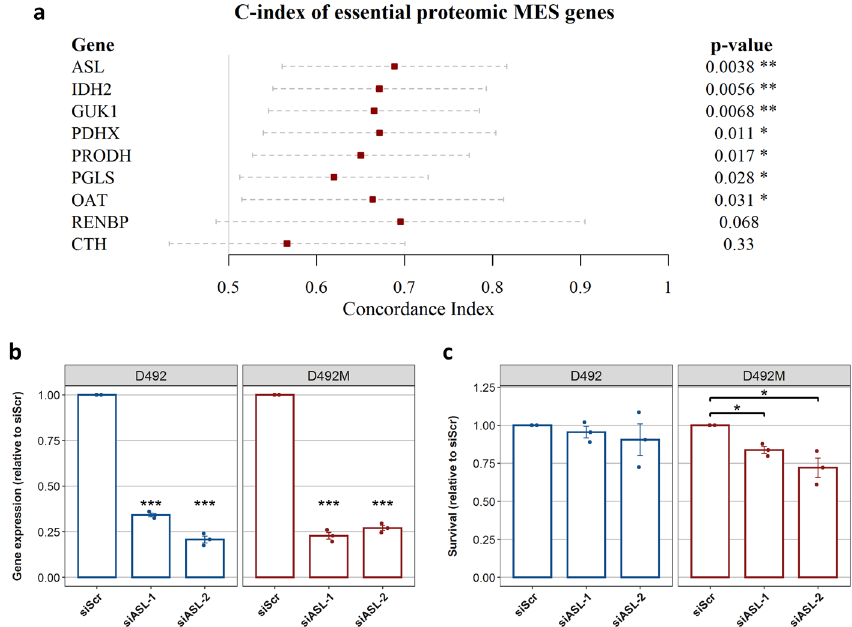
Fig. 5 Selection and knockdown of MES-essential genes. a Concordance index (C-index) of proteomic MES essential genes for overall survival prediction of patients with claudin-low breast tumors. Lines represent 95% con fi dence intervals and p values are from the calculation of the C-index using Noether ’ s method 79 . Genes are plotted in descending order based on the p values. b Expression levels of ASL in D492 and D492M after siRNA-mediated knockdown of the gene. Two different siRNA constructs were used for ASL (ASL-1 and ASL-2) ( c ) siRNA-mediated knockdown of ASL and its effects on the 96 h survival of D492 and D492M. Results in ( b ) and ( c ) are shown as mean + SEM from three experiments (shown with dots). Student ’ s t -test was used to estimate signi fi cance and p values were adjusted using the Benjamini – Hochberg approach.